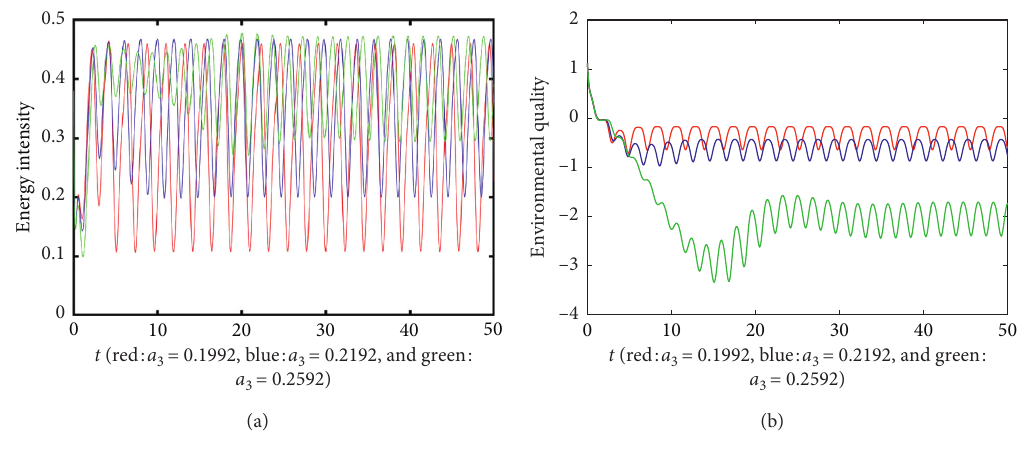
Figure 8: The parameters a